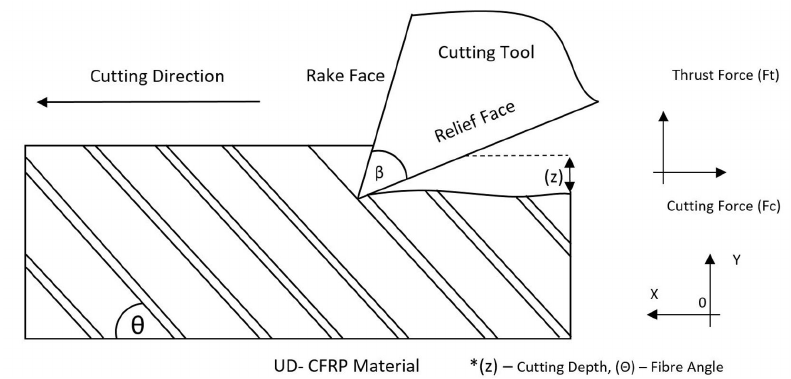
Figure 1. CFRP orthogonal cutting diagram with